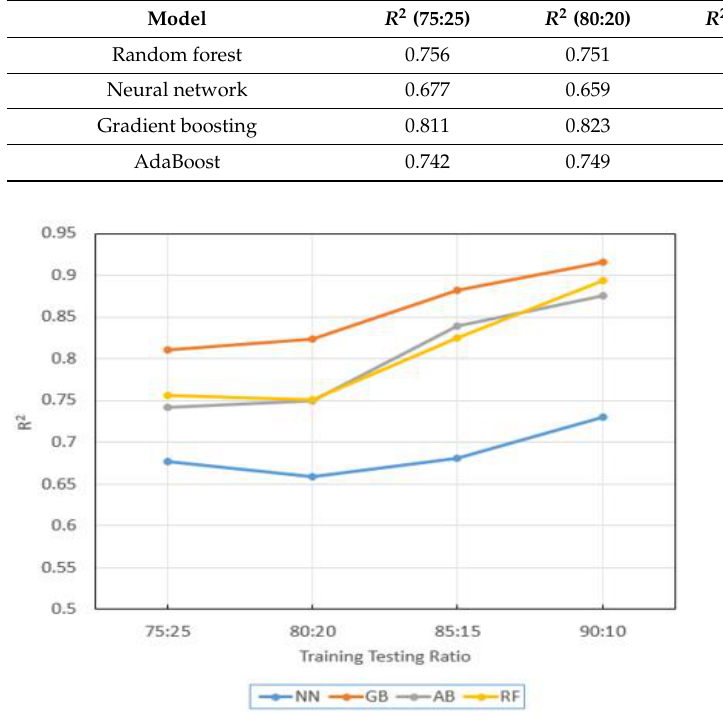
Table 11. Sensitivity analysis of ML models with different training and testing ratios. Table 11 . Sensitivity analysis of ML models with different training and testing ratios .